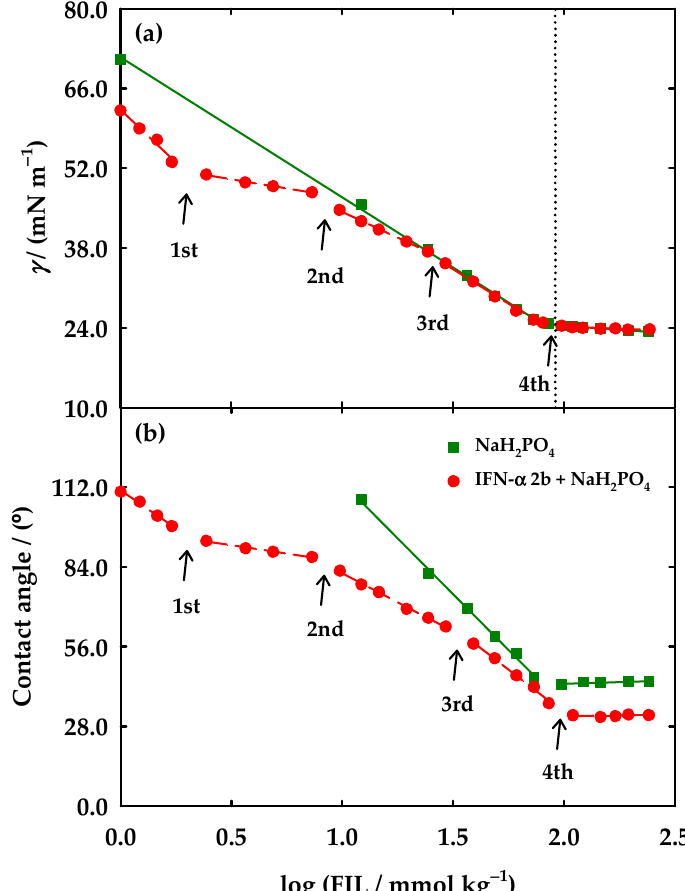
Figure 2. ( a ) Surface tension and ( b ) contact angles determined at 25 °C of [C 2 C 1 Im][C 4 F 9 SO 3 ] aqueous solution in 5 mM NaH 2 PO 4 (pH = 7.4) (green, ) and with 5 μ g/mL IFN- α 2b in 5 mM NaH 2 PO 4 (pH = 7.4) (red, ). The vertical dotted line in ( a ) represents the value of CAC determined by surface tension in water on Langmuir 2015, 31, 1283–1295 [38]. The solid and dashed lines represent the fittings to obtain the value of FIL concentration where several breakpoints occurred.